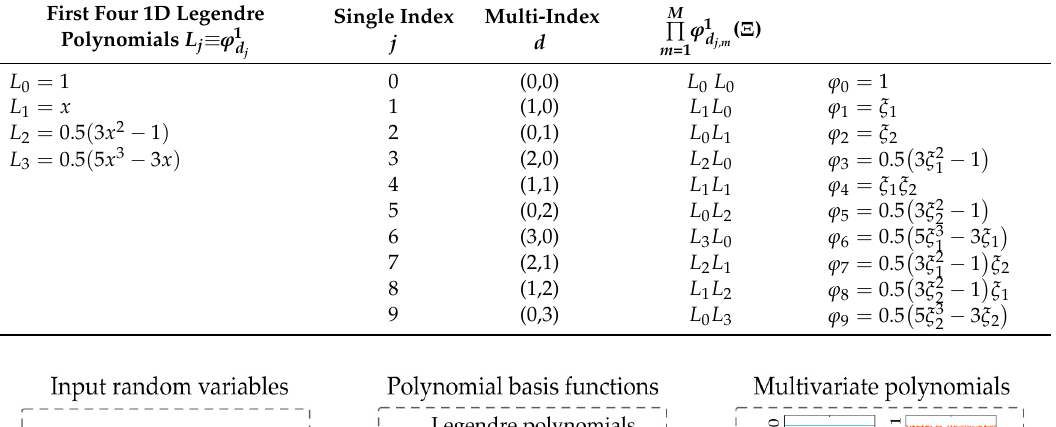
Table 1. Multivariate 2D Legendre polynomials for total polynomial order P = 3.